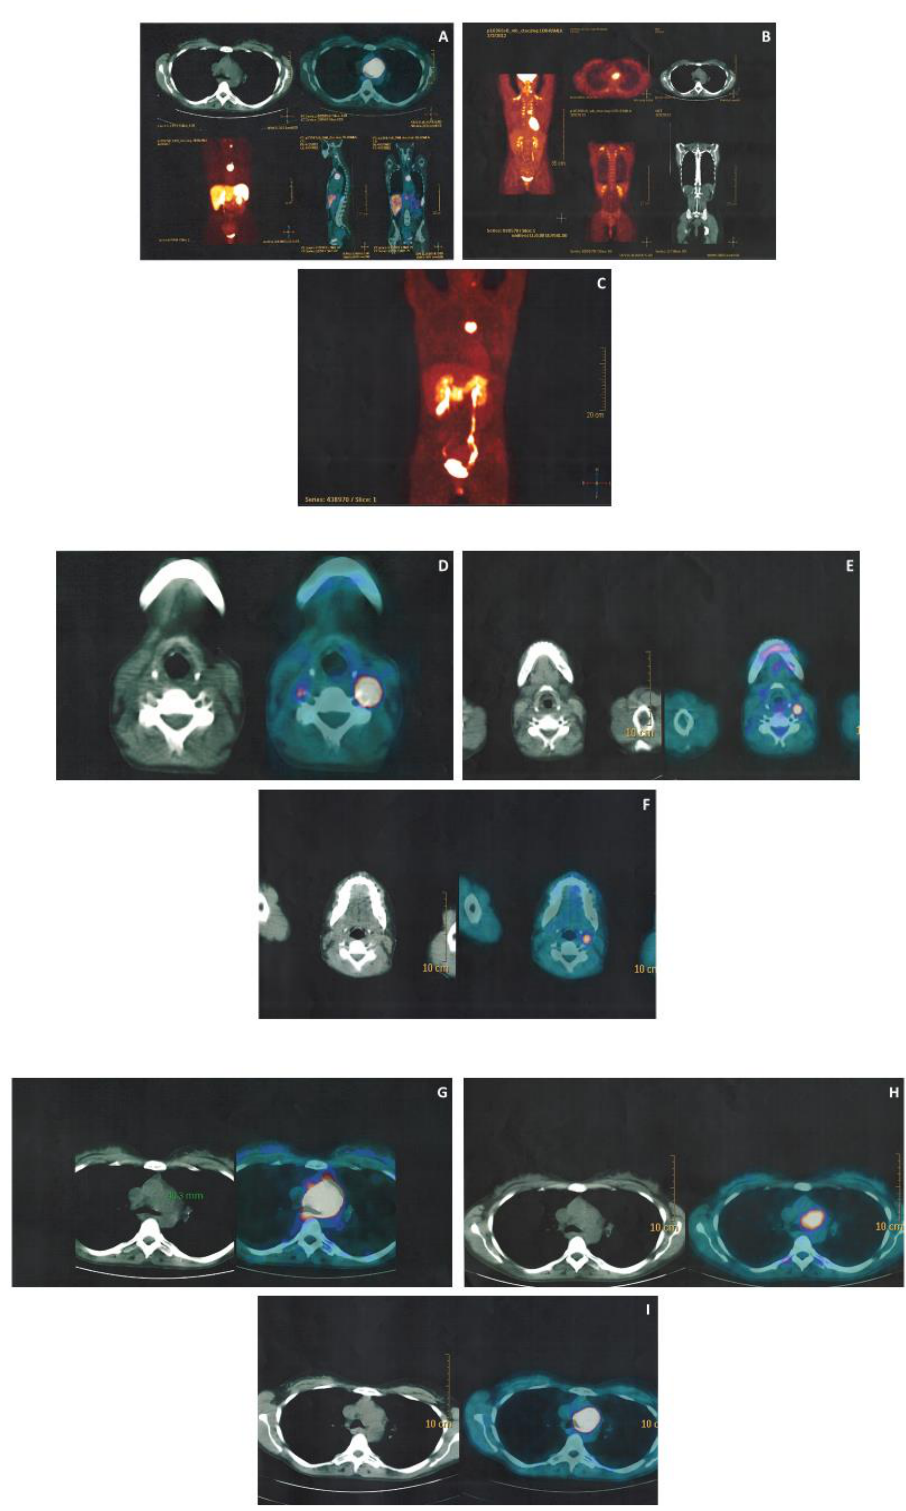
Figure 2. PET-CT comparison: ( A , D , G ): 68GaDOTATOC; ( B , E , H ): 18F-FDG; ( C , F , I ): 18F-DOPA. Abbreviations: PET = positron emission tomography; CT = computed tomography; DOTATOC = 1,4,7,10-tetraazacyclododecane-1,4,7,10-tetraacetic acid tyr3- Octreotide; FDG = fluoro-2-deoxy- D-glucose; DOPA = 3,4-dihydroxyphenylalanine.